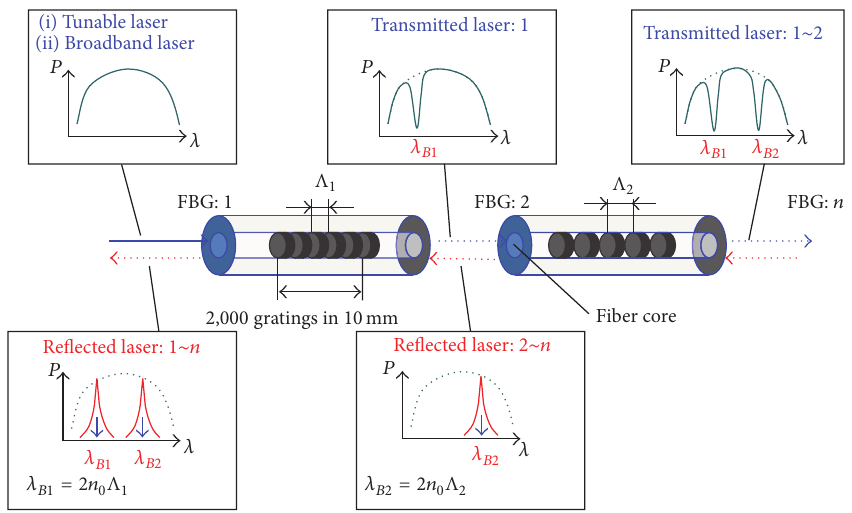
Figure 7: Schematic diagram of strain measurement method by FBG